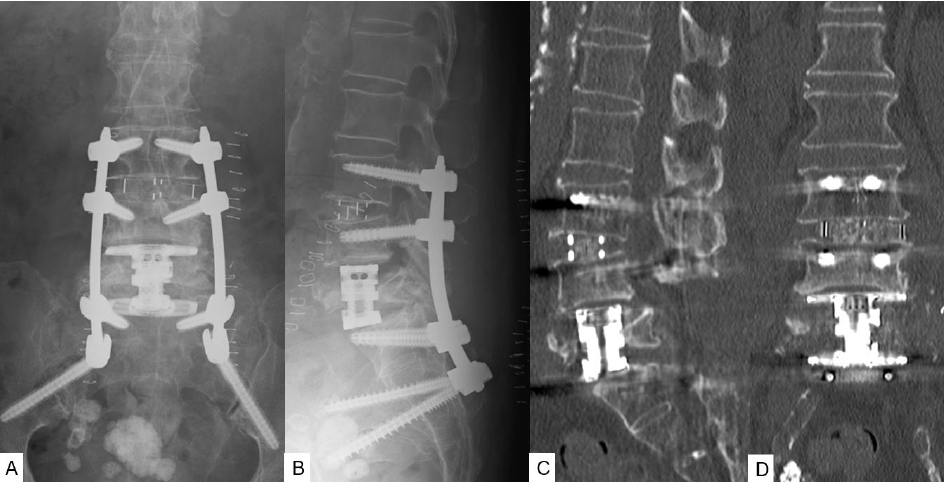
Figure 3. Postoperative images of second surgery. ( A ) Posteroanterior radiogram; ( B ) Lateral radiogram: neutral; ( C ) Mid-sagittal reconstruction CT; ( D ) Coronal reconstruction CT.